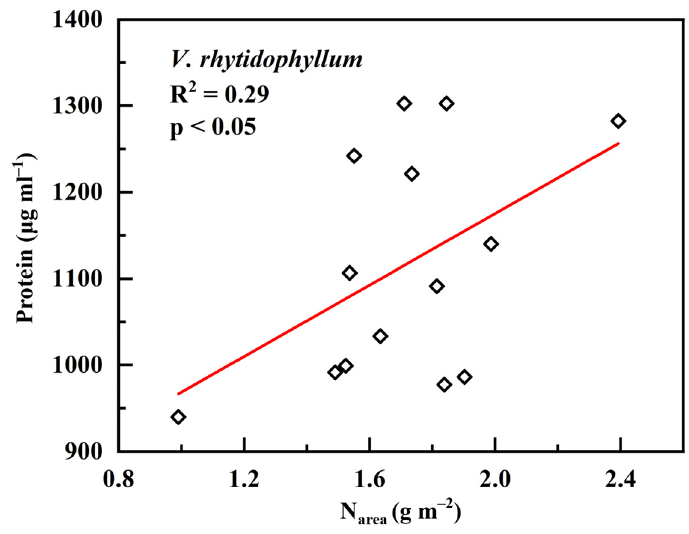
Figure 5. Relationship between leaf N based on area (N area ) and protein concentration in V. rhytidophyllum .